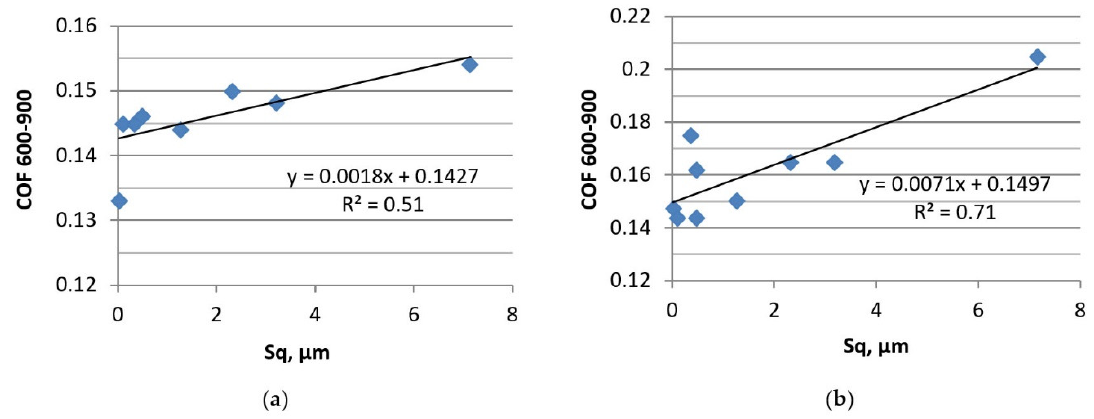
Figure 19. Dependence between the surface height of disc and the coefficient of friction in tests C ( a ) and D ( b ).